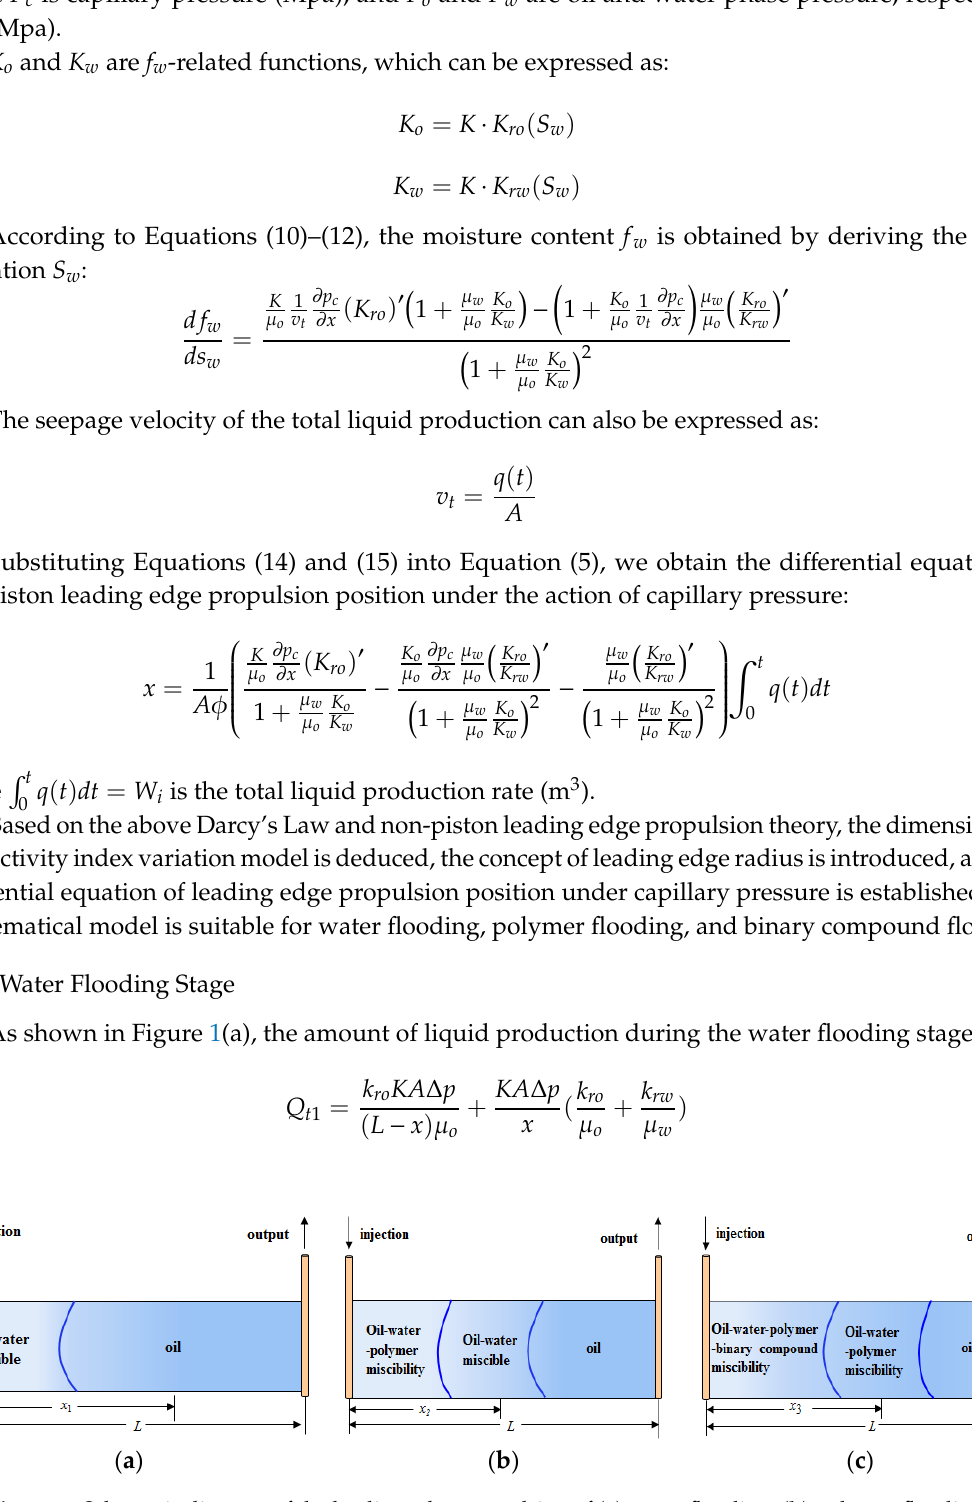
Figure 1. Schematic diagram of the leading edge propulsion of ( a ) water flooding, ( b ) polymer flooding, and ( c ) binary compound flooding stages in the multi-development phases of an oilfield.